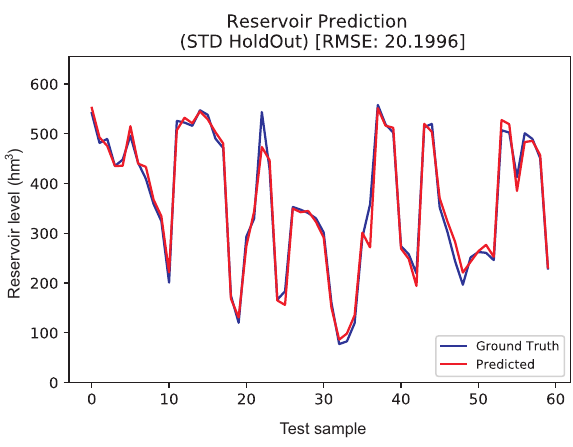
Figure 8. Ground truth vs. predicted for weekly Data, random partitioning dataset.